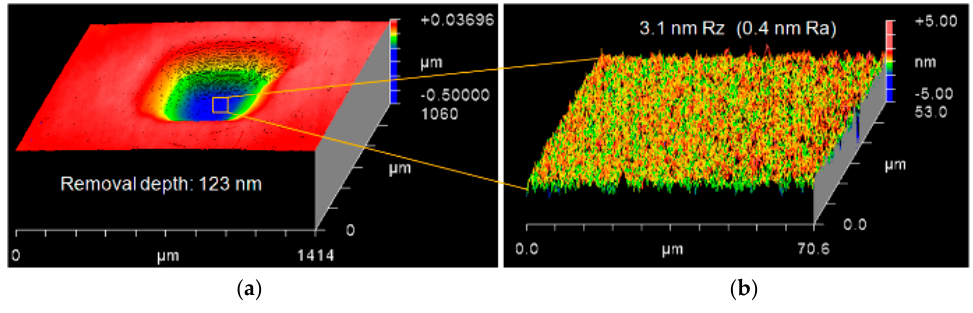
Figure 7. ( a ) Material removal depth and ( b ) surface roughness by circular vibrating motion.